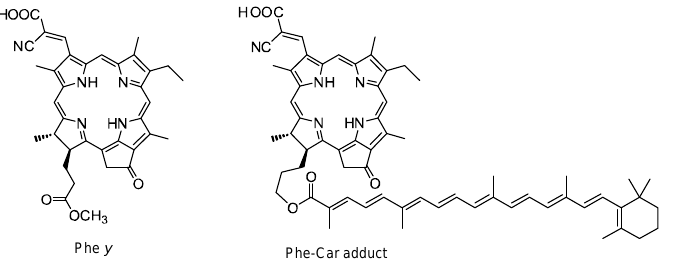
Figure 27. Chemical structures of Phe y and Phe – Car adduct (reprinted from [19], Copyright (2007), with permission from Elsevier).